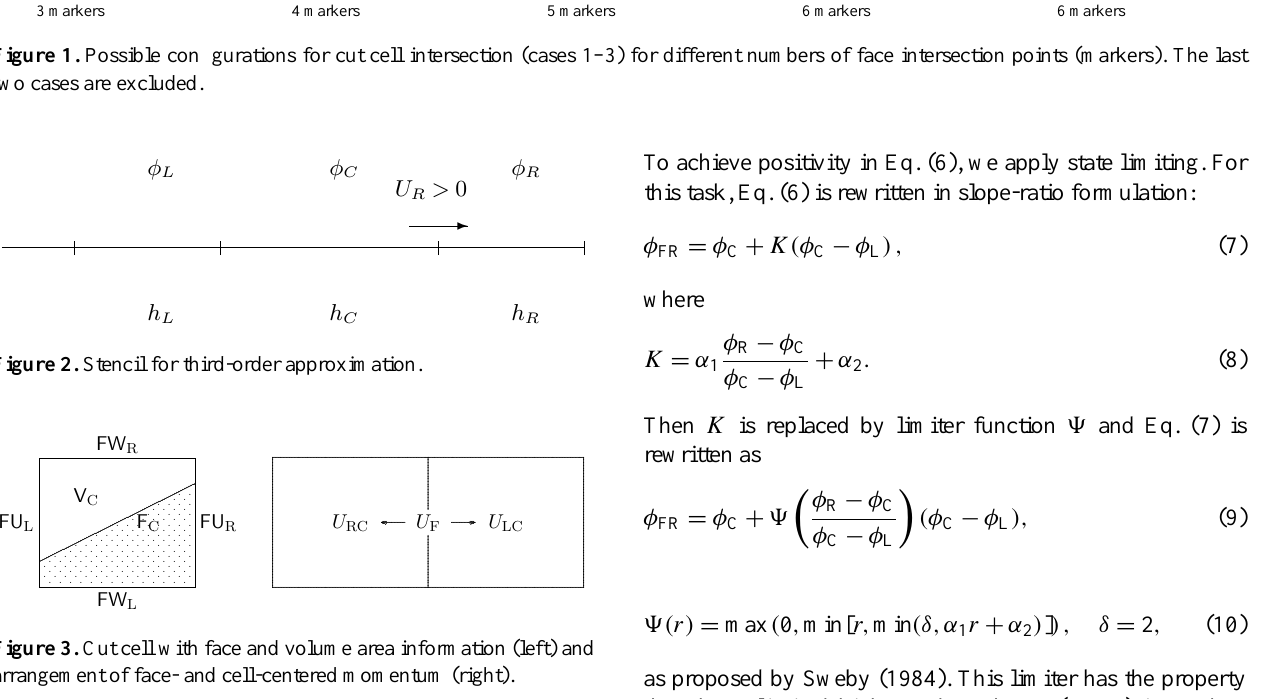
Table 2. Coefficient table for ROS2. 1 1 √ 3 or in matrix form in Table (2). + with γ = 2 6